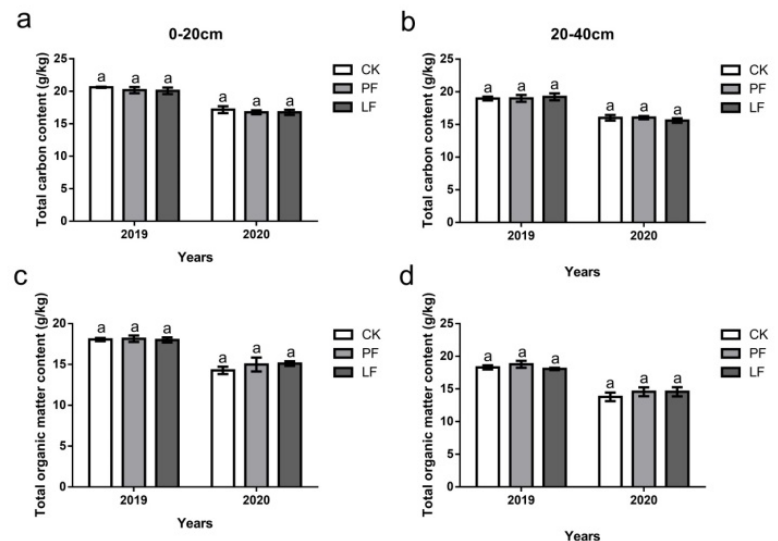
Figure 5. Effects of in-row mulching on the total carbon and organic matter contents of the soil in 2019 and 2020. ( a ): Total carbon content (0–20 cm); ( b ): Total carbon content (20–40 cm); ( c ): Total organic matter content (0–20 cm); ( d ): Total organic matter content (20–40 cm). Different letters above the columns indicate significant differences between treatments in Duncan’s multiple comparisons ( p < 0.05).